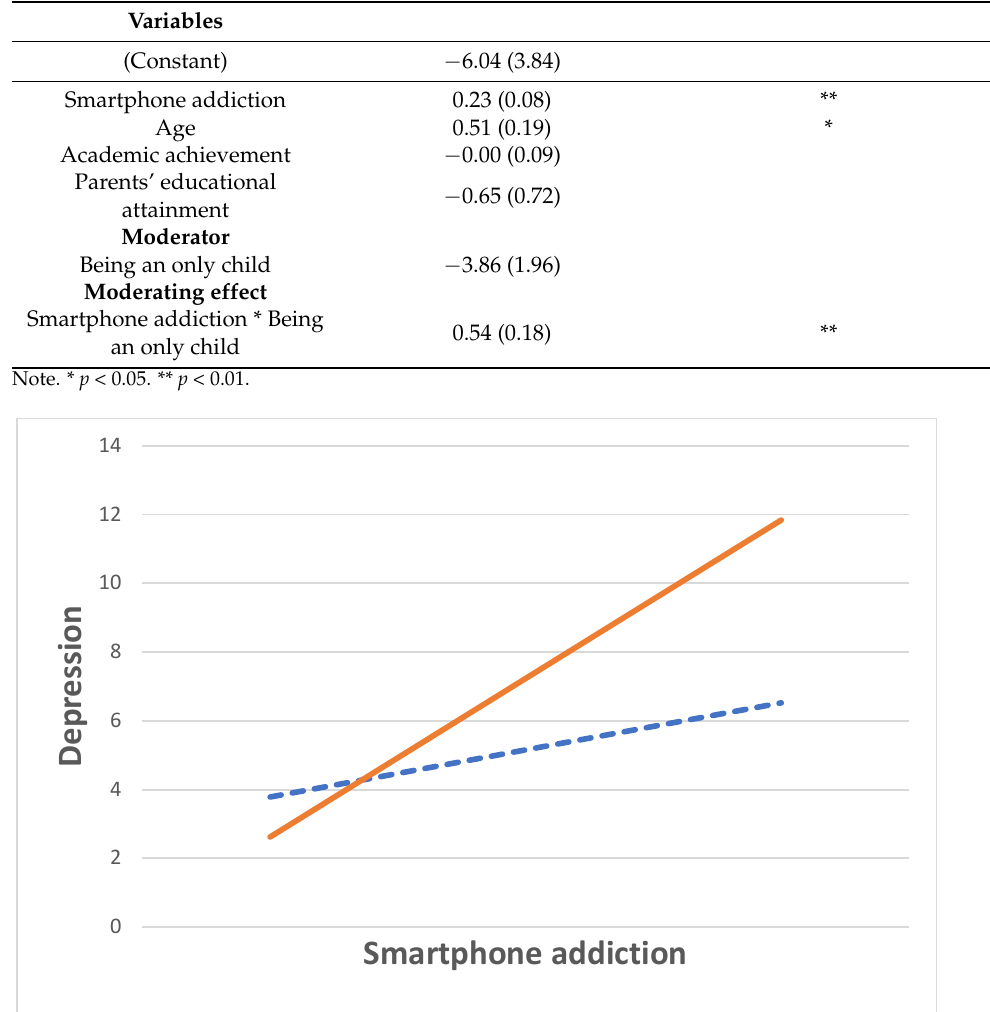
Table 2. Moderating Effects of Being an Only Child on Depression Using SPSS PROCESS.